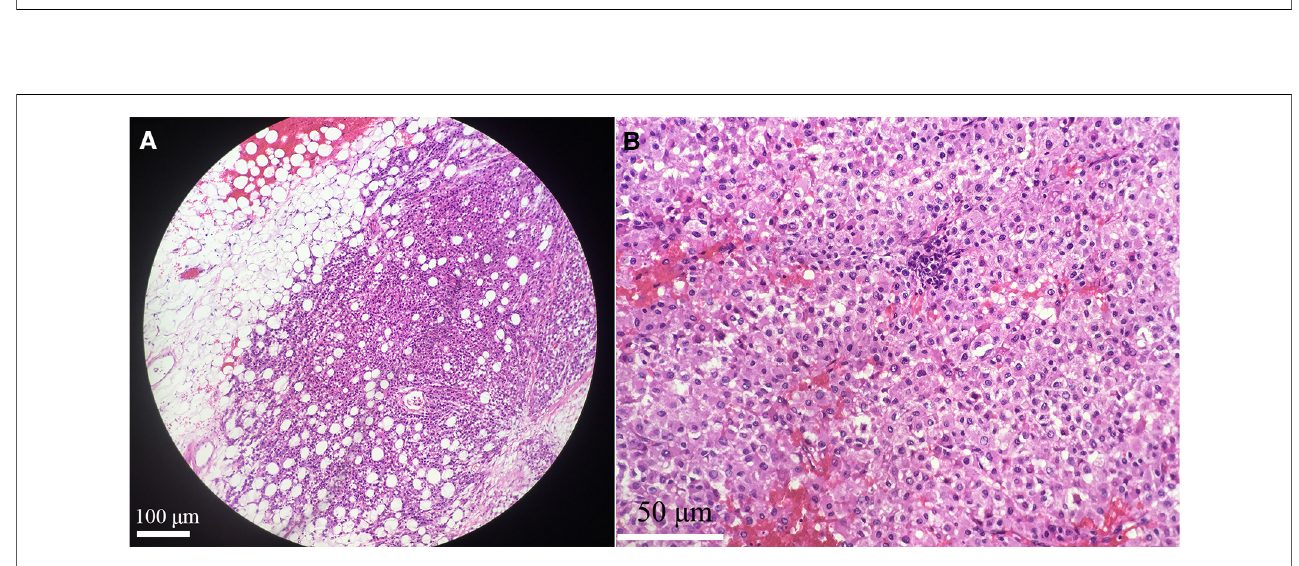
FIGURE 2 The tumor cells invaded adipose tissue, original ampli fi cation ×100 ( A ). There were obvious stromal vessels with necrosis in tumor tissue, original ampli fi cation ×400 ( B ).